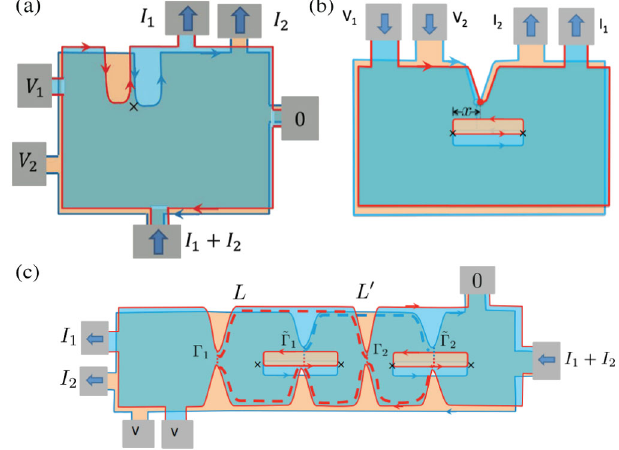
FIG. 2. Experimental setups to measure the non-trivial proper- ties of the genons/parafermion zero modes. (a) Experimental setup to measure the interlayer fractional quantized Hall con- I 1 − I 2 , is reversed as it ductance, where the exciton current, I r ¼ encounters the TLJ. The quantization at zero temperature and frequencies demonstrates that this is a resonant process closely analogous to the resonant Andreev reflection for Majorana zero modes in topological superconductors. (b) The outer edge states can be used to measure the local quasiparticle density of states, =dV through the interlayer conductance dI , thus detecting the r r exponential localization of the parafermion zero modes at the ends of the TLJ. (c) QPC interferometer setup for detecting the non-Abelian nature of the genons. Γ 1 are the amplitudes for ; 2 quasiparticle tunneling across the two QPCs in the first layer, and ~ Γ 1 ; 2 are the amplitudes for quasiparticle tunneling through the two interlayer QPCs across the TLJs. L and L 0 , indicated by the thick dashed lines, are the two interference